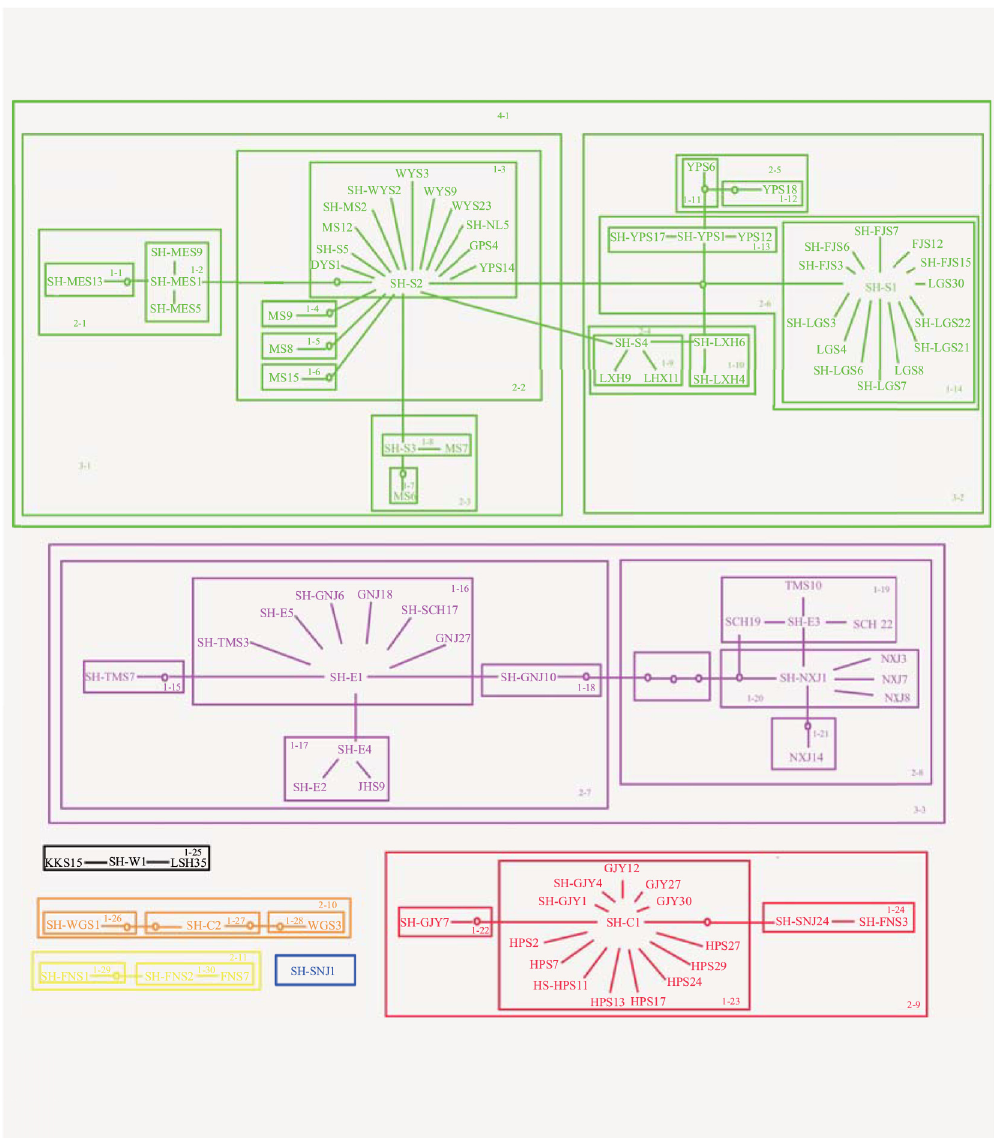
Fig 3. Haplotype networks and nested clade design for O . schmackeri species complex. Colours represent different lineages. The haplotype codes correspond to S2 Table. Unsampled haplotypes were represented by small closed